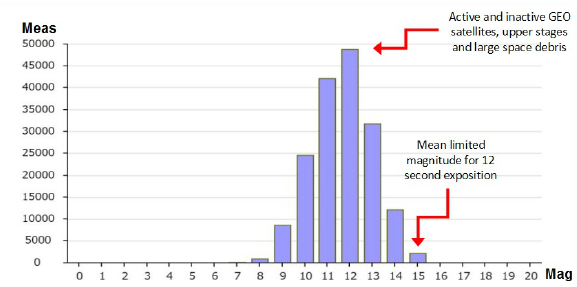
Figure 10. Magnitude distribution of ORI-25 measurements at Mon- terrey, September 2016–September 2017.